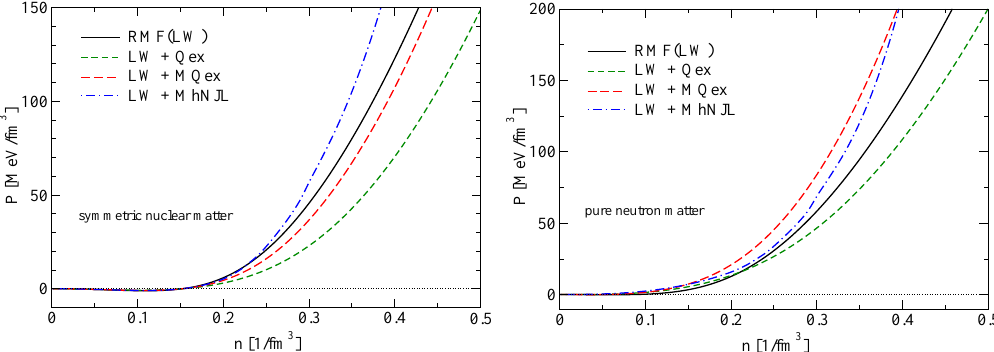
Figure 5. ( Left panel ): Pressure as a function of number density for symmetric nuclear matter. ( Right panel ): EoS for pure neutron matter for all